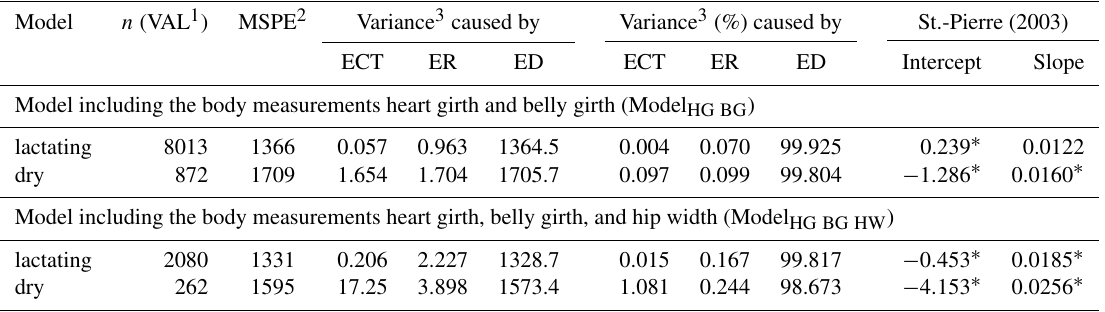
Table 6. Decomposition of root mean square prediction error (Bibby and Toutenburg, 1977) as well as the estimators for the regression of the residuals of observed and predicted body weight on the centered predicted body weight (St.-Pierre, 2003).